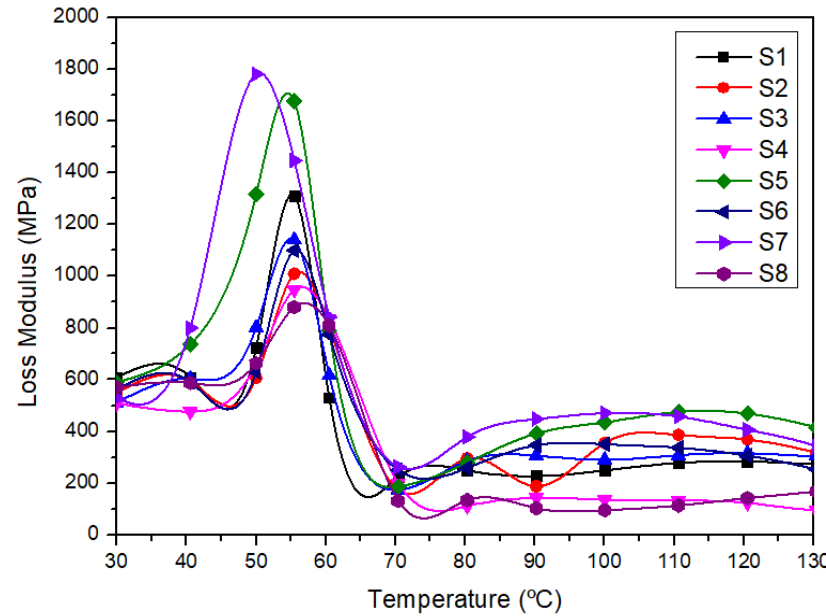
Figure 6. The loss modulus of different laminated composites.